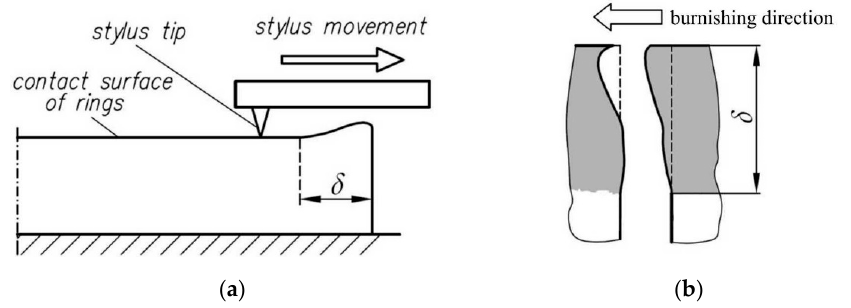
Figure 9. ( a ) Deformation of the side surfaces of adjacent rings corresponding with the plastic deformation depth δ and ( b ) measurement of the depth δ of the plastically deformed layer.